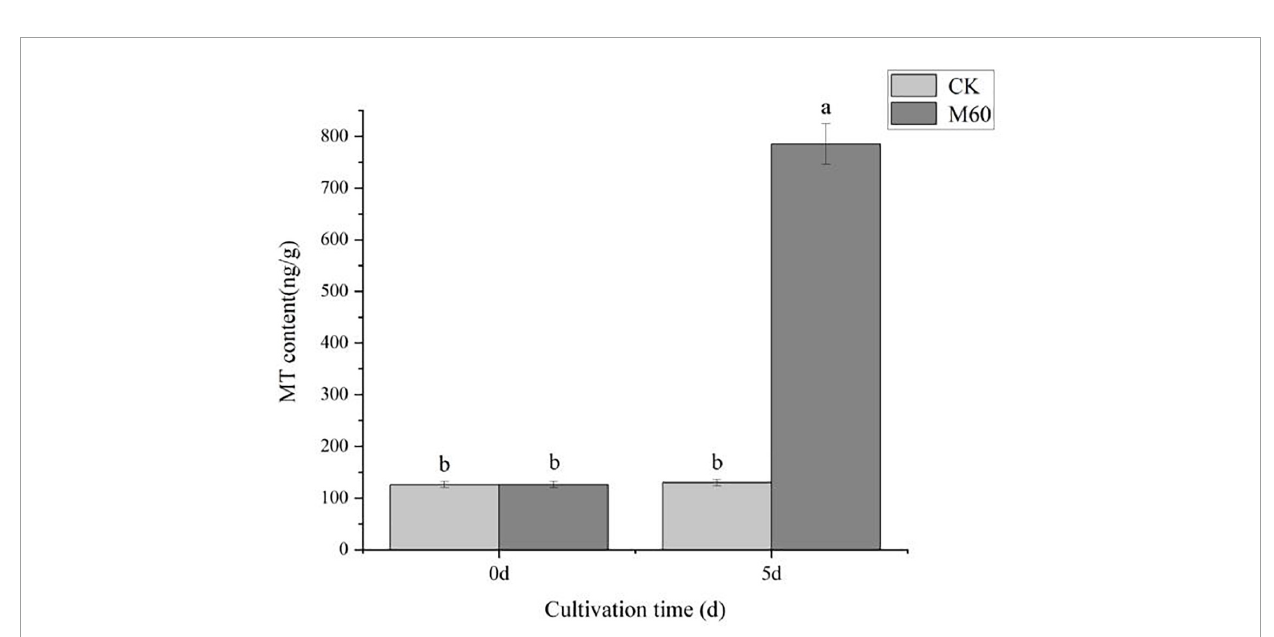
FIGURE3 Effects of exogenous MT on endogenous MT levels in C. militaris. The different letters represent significant differences among treatments according to Duncan’s multiple range tests ( p < 0.05). Data are represented as means ± SD, n = 3. M60, add 60 µ mol L − 1 of MT.